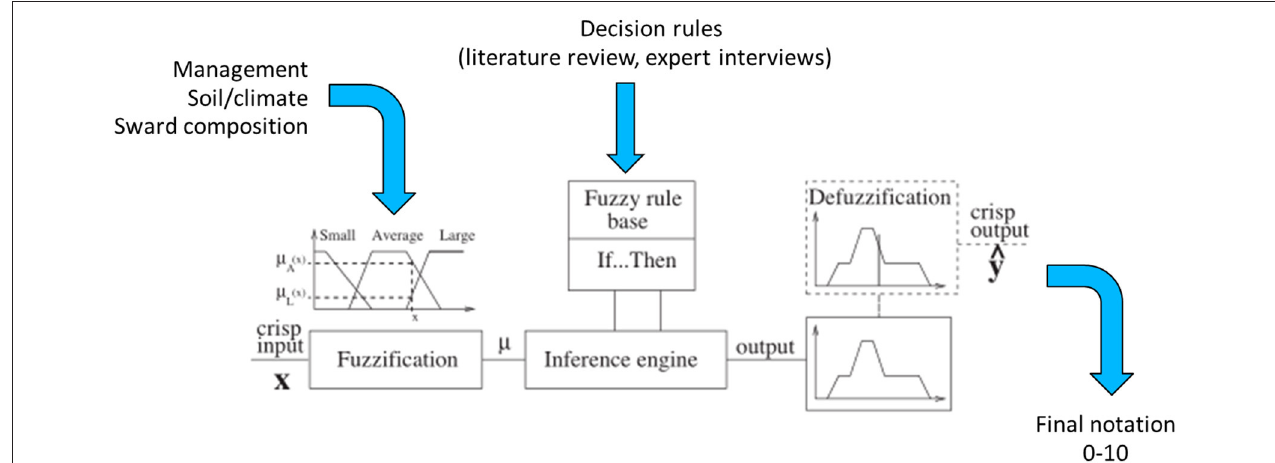
FIGURE 1 | Components of a fuzzy inference system (adapted from Suárez and Lutsko, 1999).